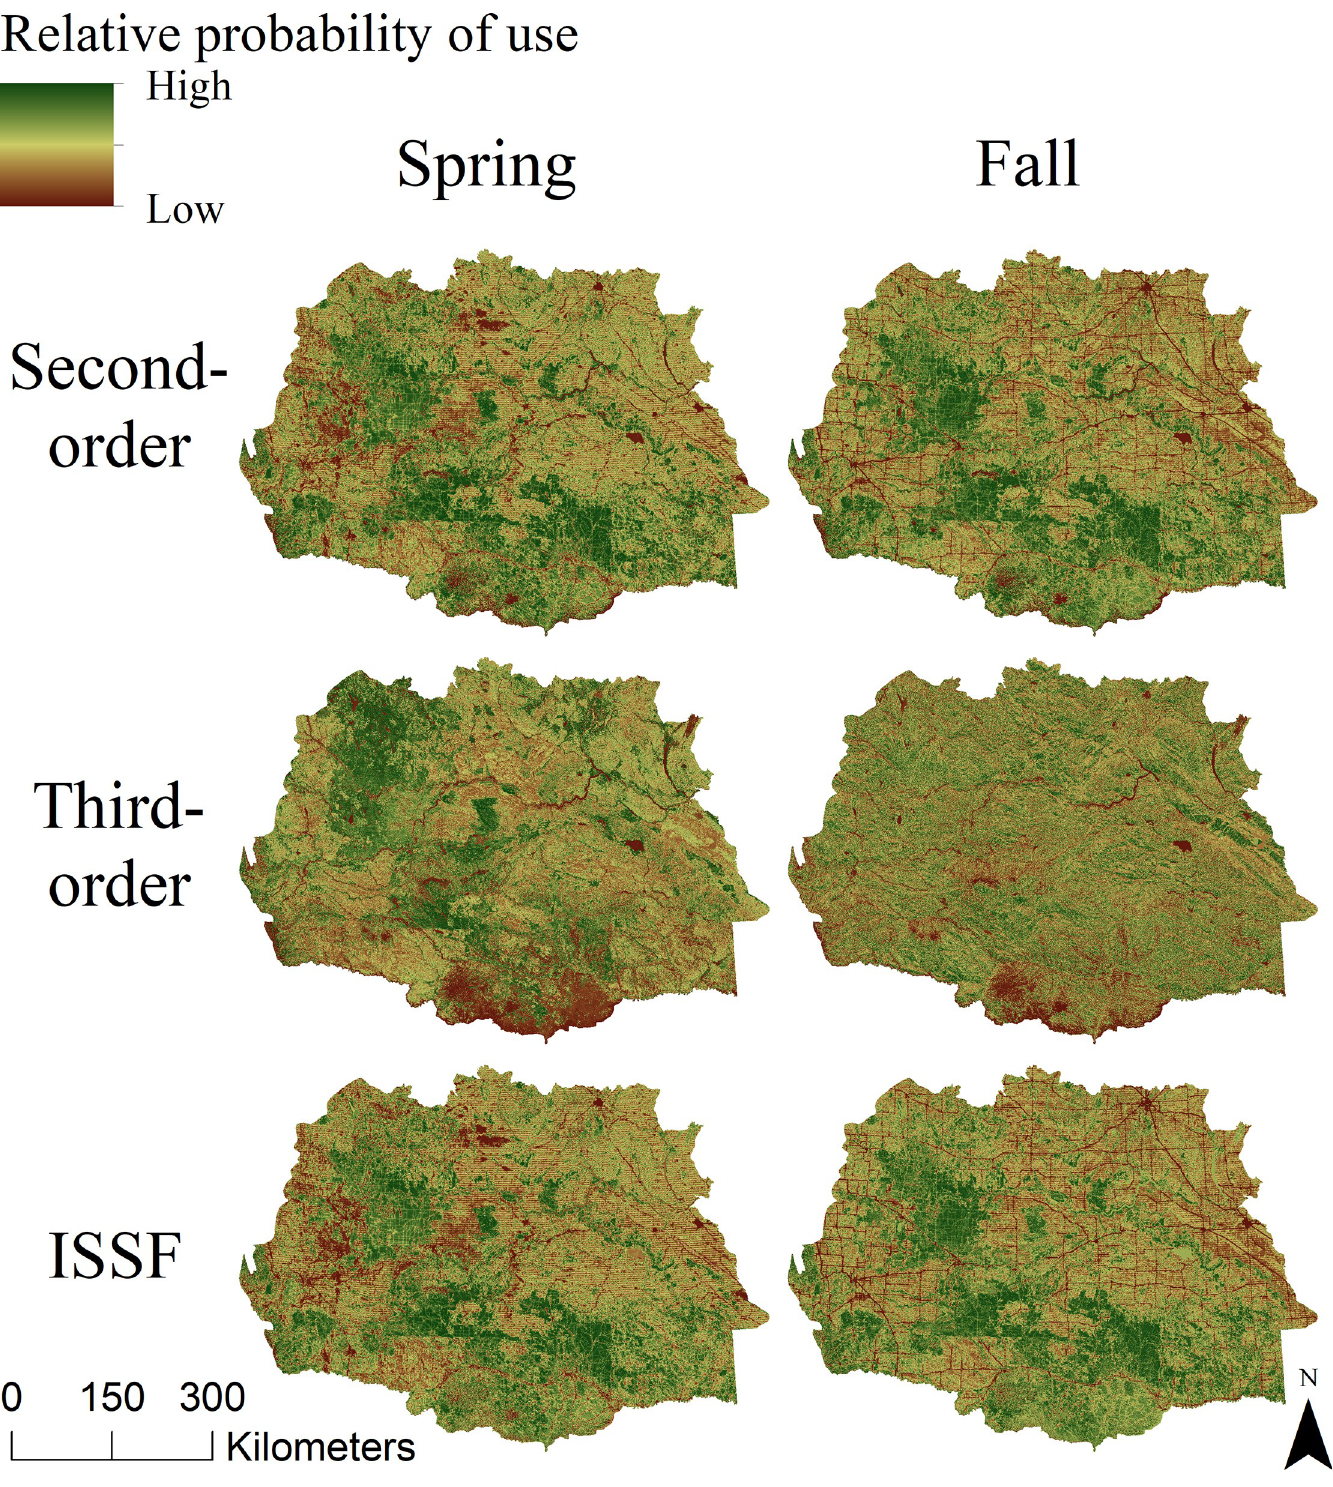
Fig 2. Resource selection spatial predictions for female pronghorn across the Northern Sagebrush Steppe from 2004–2010 during spring and fall migrations. Second-order selection during spring and fall are identified in the first row, third-order selection during seasonal migrations are identified in the second row, and scale- integrated step selection function (ISSF) map during seasonal migrations are identified in the third row. ISSF was calculated by multiplying the second- and third-order selection values across the Northern Sagebrush Steppe into a scale-integrated spatial prediction. This figure presents original map predictions that predicts the probability of use by pronghorn where green pixels indicate high probability areas for migration habitat, while red pixels indicate low probability areas.